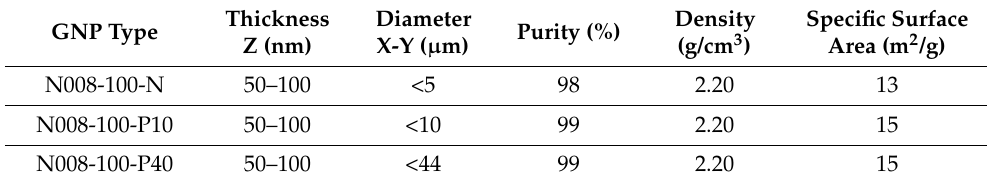
Table 1. Physical properties of GNPs.